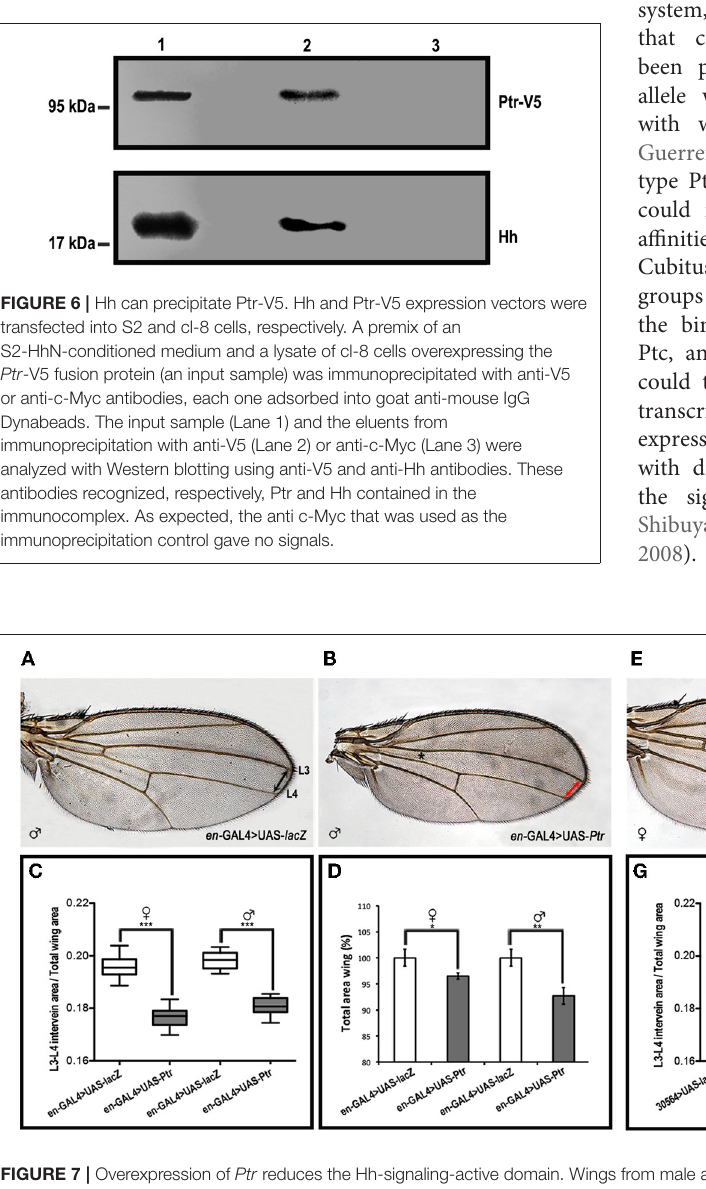
Frontiers in Neuroscience |